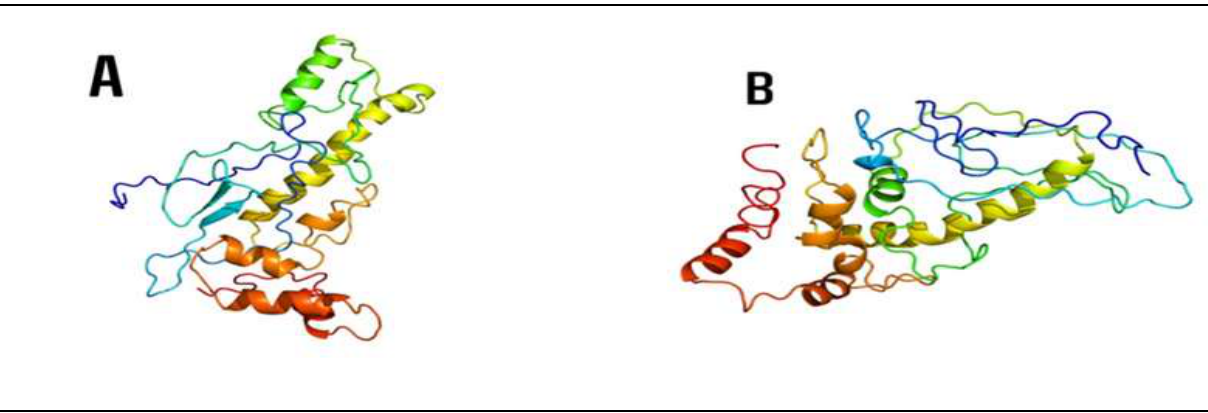
Figure 5: The secondary structure of TCF7L2 that retrieved from (NCBI). The results of TCF7L2 protein tertiary structure for patients with T2DM that compared with the 3D structure of the TCF7L2 protein from NCBI by using the Phyre2, those the tertiary structure of TCF7L2 gene in patients with diabetes appeared out of the templates the provided by Phyre2 tool (Figure 6). The highest % I.d (94%) was used to predict the 3D structure.